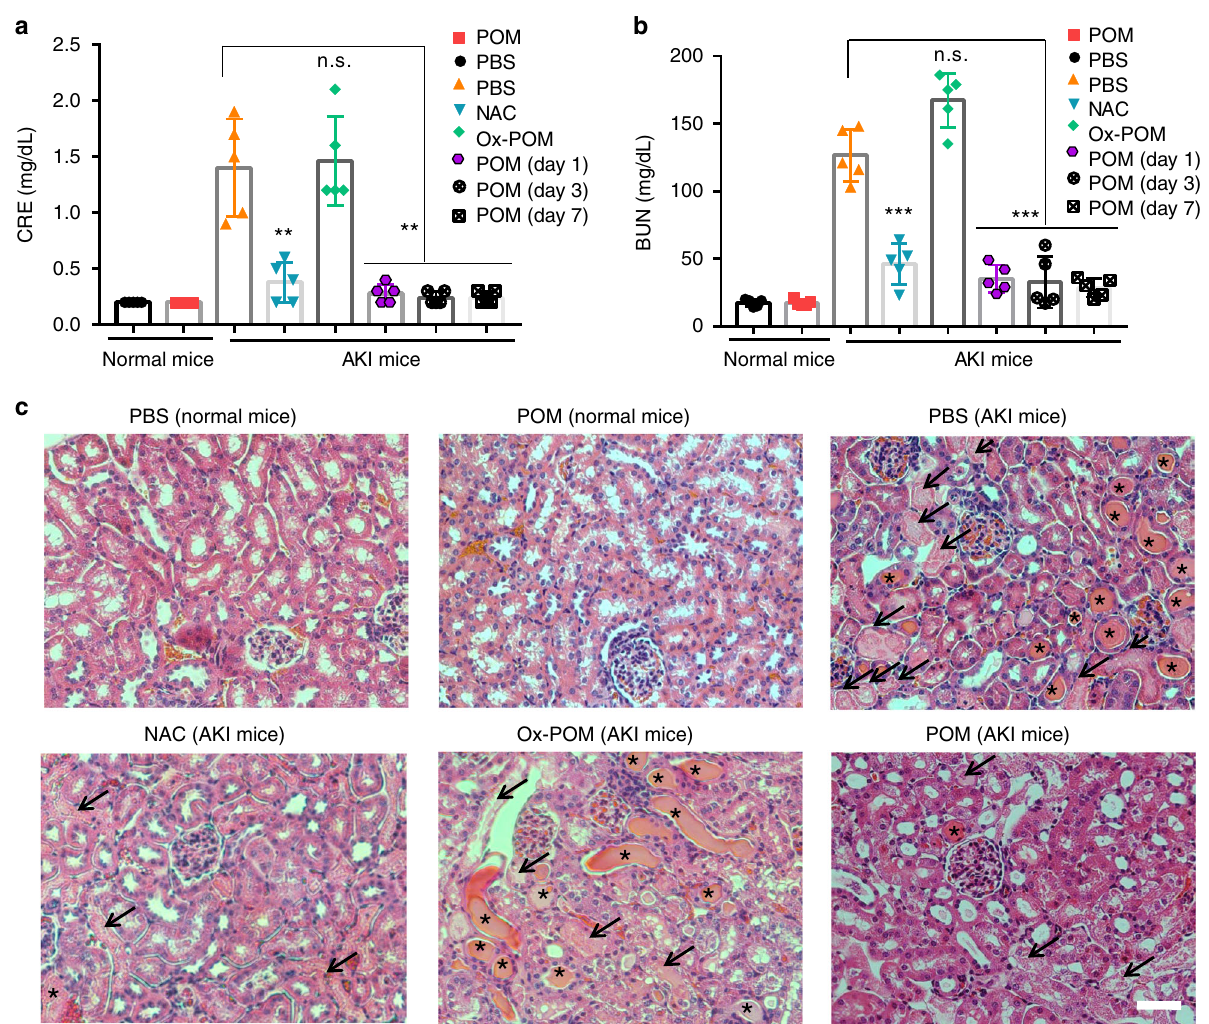
Fig. 5 Blood serum measurements and H&E staining of renal tissue after treatment of AKI. BUN ( a ) and CRE ( b ) levels in the blood serum from each group. Lower BUN and CRE levels denote better kidney functions. c H&E staining of kidney tissues from each group. Arrows indicate damaged tubules, and asterisks indicate the formation of casts. Scale bar: 50 µ m. In a and b , data represent means ± s.d. from fi ve independent replicates, and P values were calculated by two-tailed Student ’ s t -test (** P < 0.01; *** P < 0.001; n.s. no signi fi